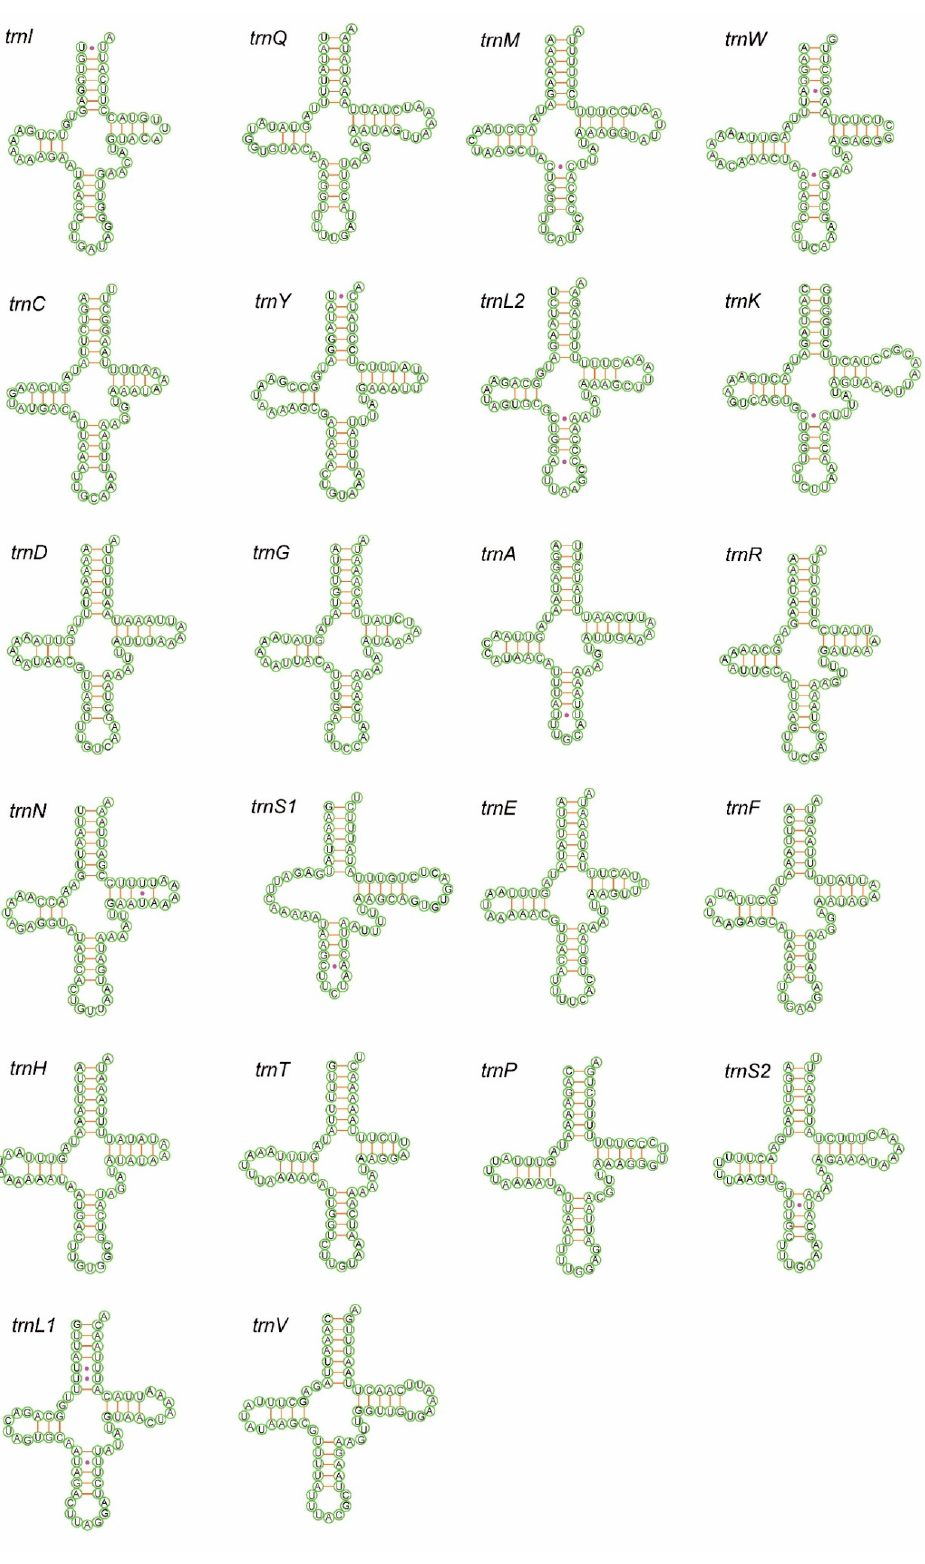
Figure 5. Inferred secondary structure for the tRNAs of Epuraea